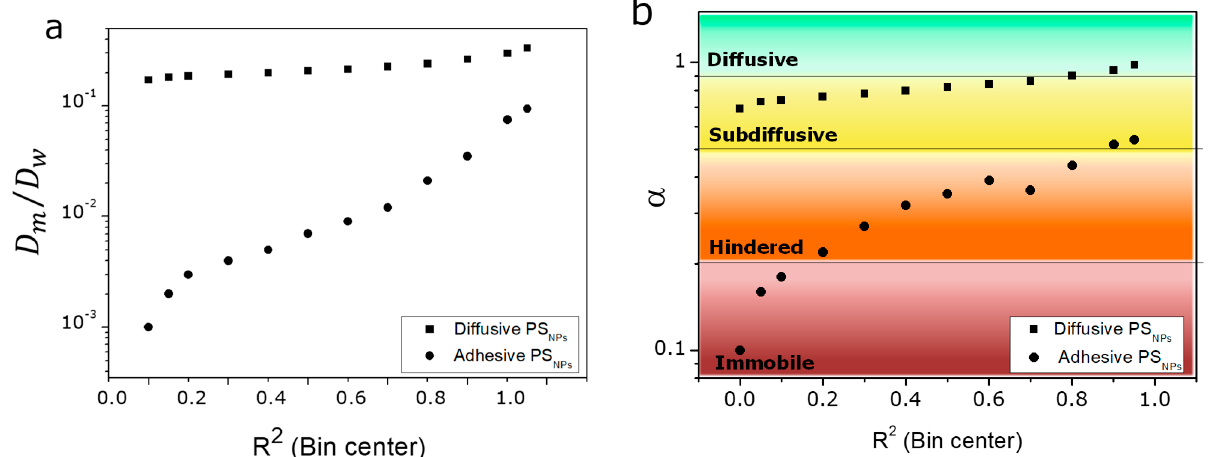
2 on ( a ) D m /D w , ( b ) α value of PS NPs